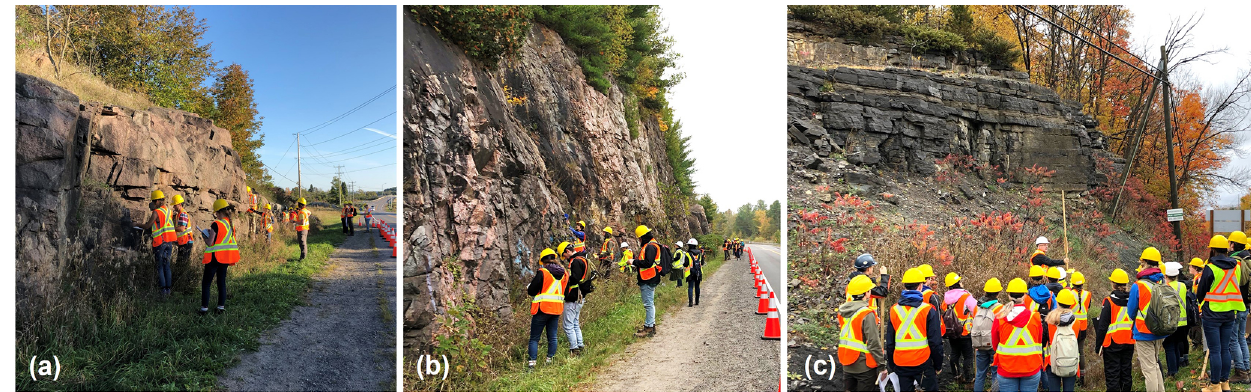
Figure 1. Example field trip locations in the Kingston area of GEOE/L 221 in person. (a) Field trip 2 (Joyceville, featuring a syenite pluton). (b) Field trip 4 (Perth Road, featuring a Proterozoic gneiss). (c) Field trip 6 (Moreland-Dixon Road part 2, featuring Ordovician carbonate sedimentary stratigraphy).